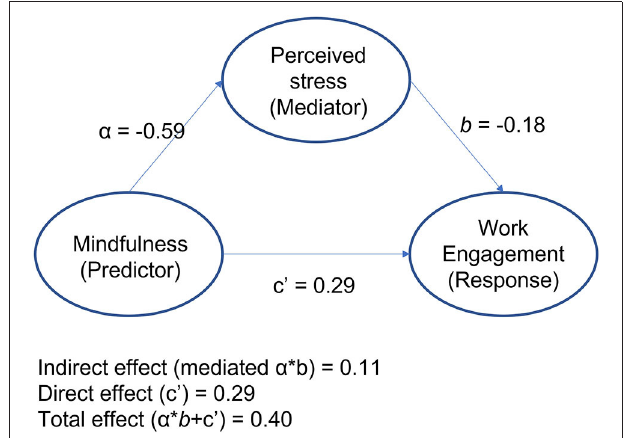
FIGURE 1 | Mediation path showing direct and indirect effects of mindfulness on work